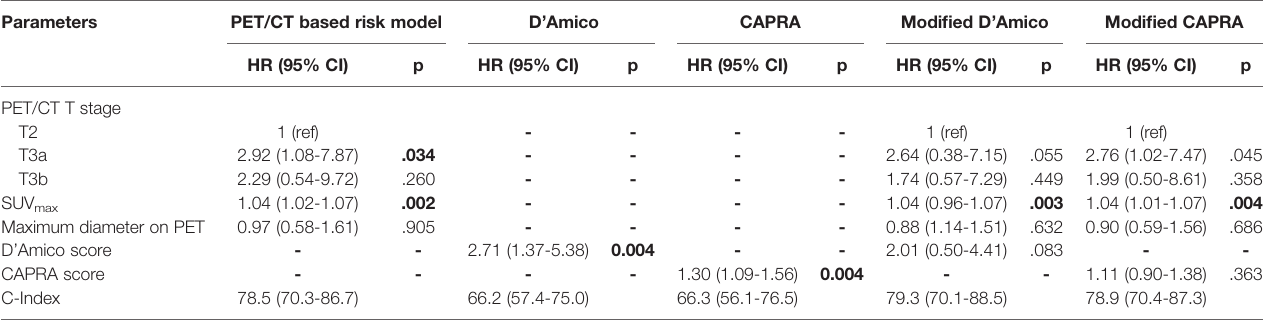
TABLE 2 | Cox regression analyses assessing the prediction models of biochemical recurrence in prostate cancer patients treated with radical prostatectomy.